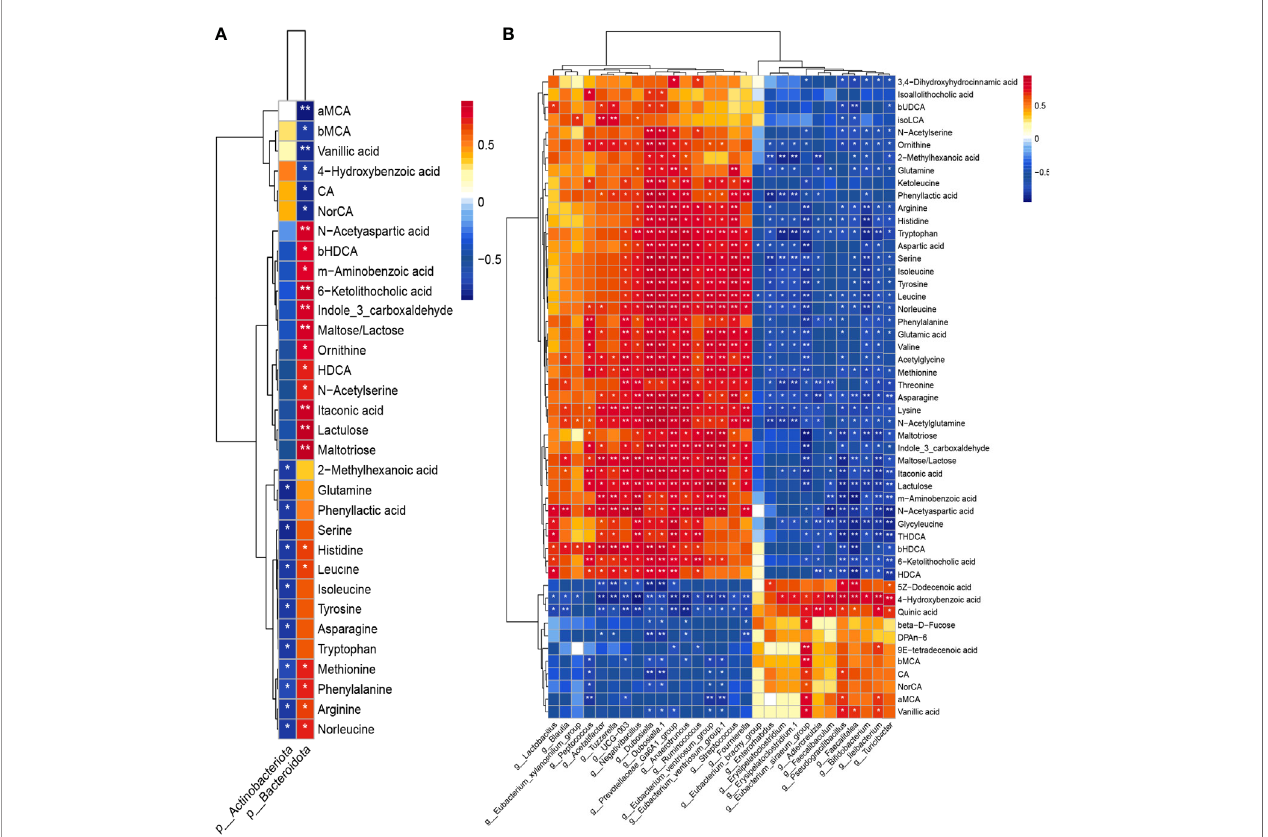
FIGURE 9 | Heatmap of Spearman ’ s correlation coef fi cients between colonic microbiota and fecal metabolites on phylum level (A) and on genus level (B) . Blocks in red and blue denote high and low correlation coef fi cients, respectively. * P < 0.05, ** P <